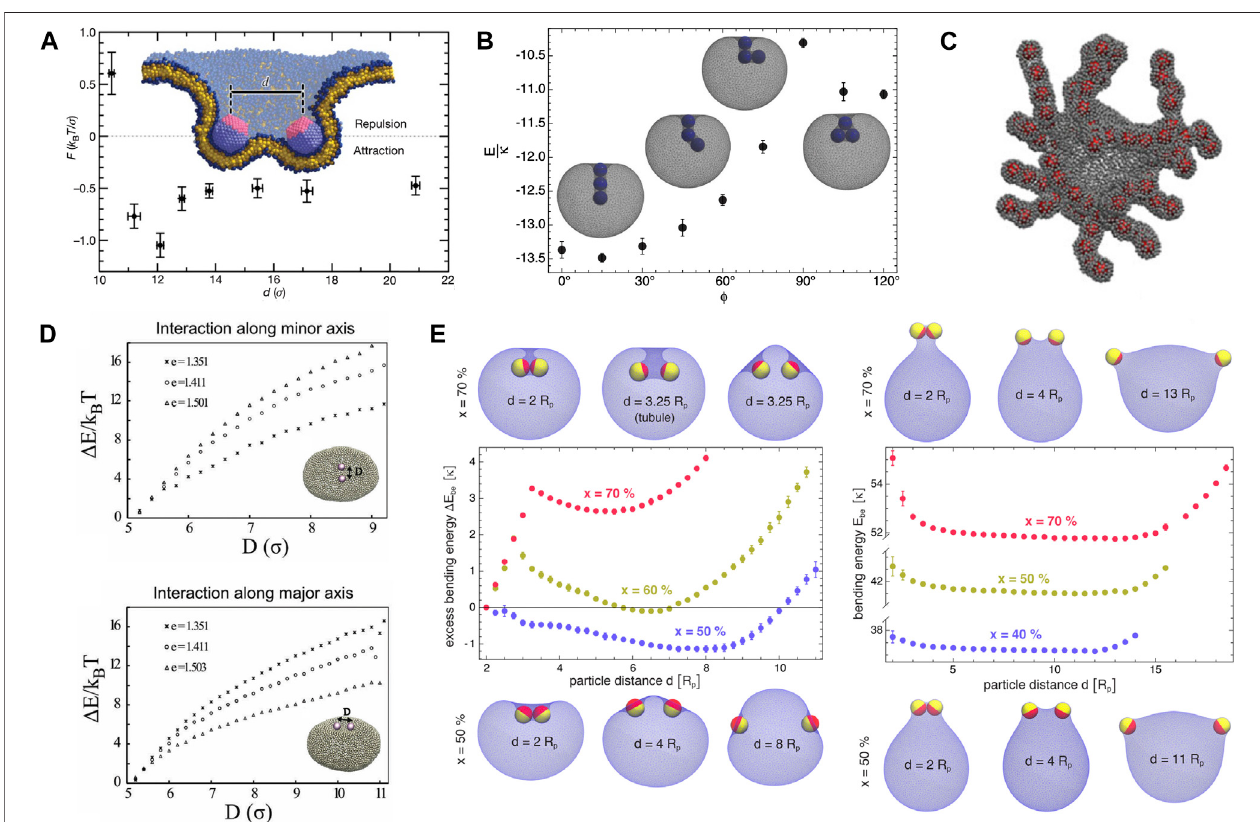
FIGURE 4 | Membrane-mediated interactions between quasi-spherical or spherical particles adsorbed on fl uid membranes obtained from coarse-grained MD or MC simulations. (A) Force F versus center-to-center distance d between two capsids (diameter of 8 nm) strongly bound to a fl uid bilayer. Reprinted by permission from Springer Nature Customer Service Centre GmbH: Reynwar et al. (2007), Copyright (2007). The minimal attraction at d ≈ 12 σ (cid:1) 12 nm is about k B T / σ ∼ 4 pN. (B) Rescaled totalenergy E / κ ofavesiclewith three adsorbed particles wrapped bymembranetubes asafunctionofthe angle ϕ between theparticles(Bahramiet al., 2012), copyright (2012) by the American Physical Society. Insets are energy-minimum con fi gurations for ϕ (cid:1) 0 ° , 45 ° , 90 ° , and 120 ° . The most stable con fi guration corresponds to linear aggregation of the three particles inside the membrane tube, re fl ecting membrane-mediated strong attraction between the particles. The vesicle membrane has a fi xed area of A and a fi xed enclosed volume of V (cid:1) 0 . 88 × ( 4 π /3 )[ A / ( 4 π )] 3/2 . The particle-membrane adhesion energy per area is U (cid:1) 2 κ / R 2 p with κ membrane bending rigidity and R p particle radius. (C) Snapshot of aggregates of spherical particles adsorbed to vesicular membranes from MC simulations at constant temperature ( Š ari ć and Cacciuto, 2012b), copyright (2012) by the American Physical Society. (D) Interaction energy Δ E versus distance D of two spheres bound to an ellipsoidalvesiclewitheccentricity e (Vahidetal.,2017),withpermissionofTheRoyalSocietyofChemistry. (E) Excessbendingenergy Δ E be ofavesicleversusdistance R of two Janus spherical particles adhered to the outside (left panel) or inside (right panel) of the membrane, reprinted with permission from Bahrami and Weikl (2018), copyright 2018 American Chemical Society. The adhesive cap in yellow is fully covered by the membrane and has an area fraction of x . For x (cid:1) 60 % and 70%, the increase of Δ E be at small values of d corresponds to curvature-induced elastic attraction between the particles. The decrease of Δ E be at intermediate values of d corresponds to curvature-induced repulsion between the particles.